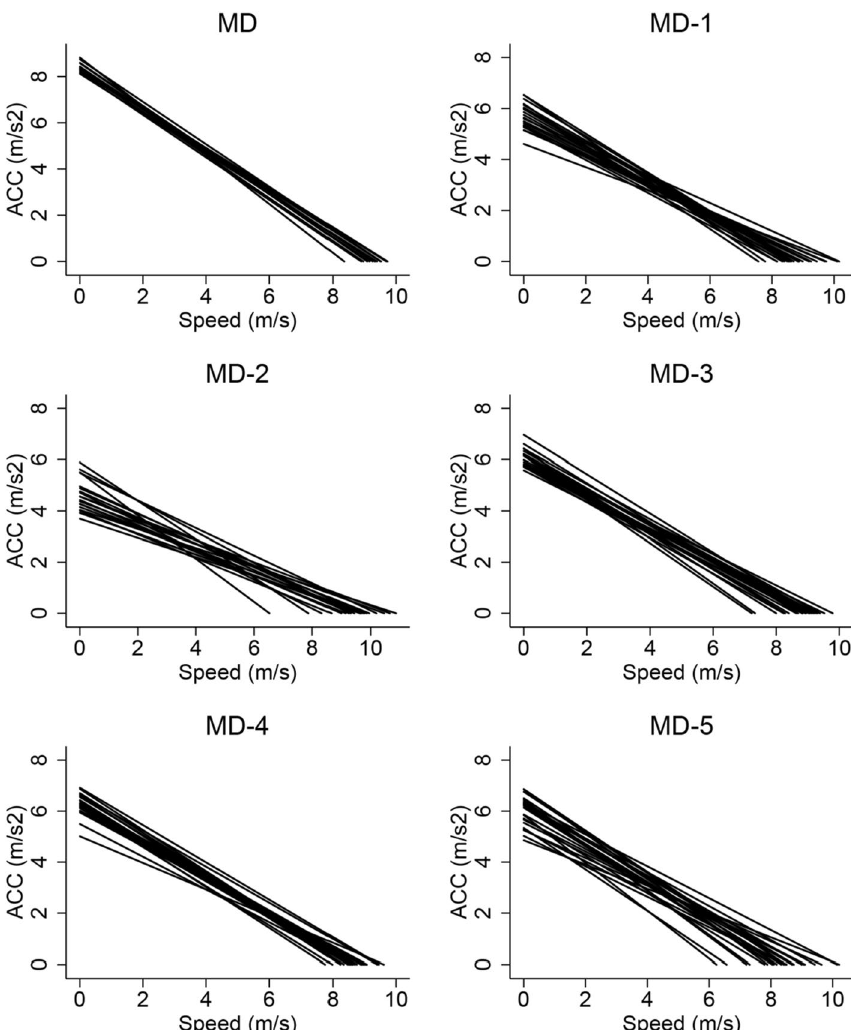
Figure 1. Acceleration-speed profile of elite football players on different training and match days in the microcycle. Acc = acceleration (m/s2); Speed (m/s). MD =